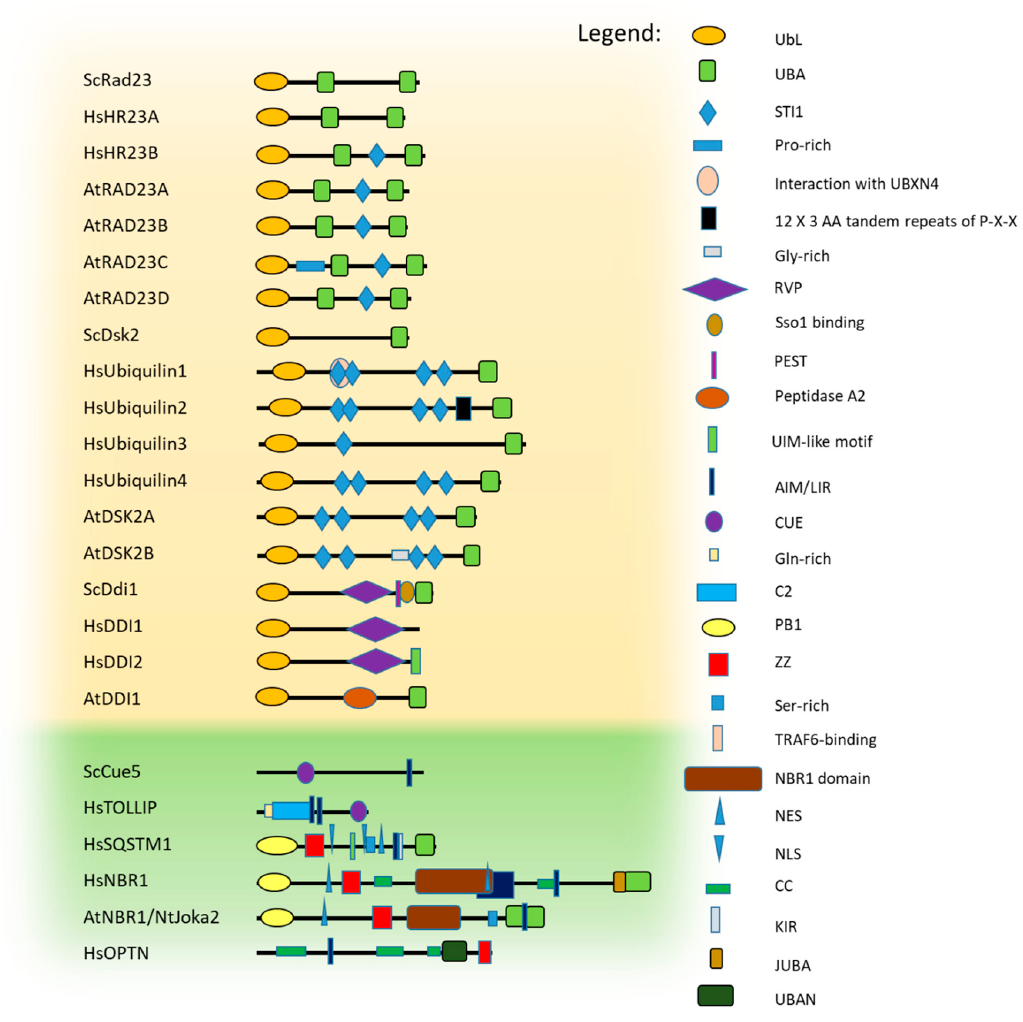
Figure 2. Ub-binding protein shuttles from yeast, mammals, and plants. Schematic representation of the domain/motif/region organization of the known Ub-binding shuttle receptors used by the proteasomal [59] and autophagic [24,65–67] protein quality control (PQC) pathways. The graphical depiction of Ub-binding modules is based on their identification using UniProt and extended by data in the published literature [68,69]. The domain/motif/regions are shown for the proteasomal ( S. cerevisiae Rad23 (P32628), H. sapiens HR23A (P54725), H. sapiens HR23B (P54727), A. thaliana RAD23A (Q84L32), A. thaliana RAD23B (Q84L33), A. thaliana RAD23C (Q84L31), A. thaliana RAD23D (Q84L30), S. cerevisiae Dsk2 (P48510), H. sapiens ubiquilin1 (Q9UMX0), H. sapiens ubiquilin2 (Q9UHD9), H. sapiens ubiquilin3 (Q9H347), H. sapiens ubiquilin4 (Q9NRR5), A. thaliana DSK2A (Q9SII9), A. thaliana DSK2B (Q9SII8), S. cerevisiae Ddi1 (P40087), H. sapiens DDI1 (Q8WTU0), H. sapiens DDI2 (Q5TDH0), A. thaliana DDI1 (Q1EBV4)), and autophagic shuttles ( S. cerevisiae Cue5 (Q08412), H. sapiens TOLLIP (Q9H0E2), H. sapiens SQSTM1 (Q13501), H. sapiens NBR1 (Q14596), A. thaliana NBR1 (Q9SB64), N. tabacum Joka2 (F8RP79), and H. sapiens OPTN (Q96CV9)). All proteins and domains are drawn to scale. UbL, Ubiquitin-like. UBA, Ubiquitin-associated. STI1, stress-inducible 1. UBXN4, Ubiquitin-regulatory X domain-containing protein 4. RVP, retroviral protease fold domain. PEST, protein rich in Pro, Glu, Ser and Thr. UIM, Ub-interacting motif. AIM/LIR, ATG8-interacting motif/LC3-interacting region. CUE, coupling of Ub-conjugation to ER degradation. C2, Ca +2 -dependent membrane-targeting module. PB1, Phox and Bem1. ZZ, Zinc finger. TRAF6, TNF receptor-associated factor 6. NBR1, Neighbor of BRCA1. NES, Nuclear Export Signal. NLS, Nuclear Localization Signal. CC, coiled-coil. KIR, KEAP1 (Kelch-like ECH-associated protein 1)-interacting region. JUBA, Juxta-UBA. UBAN, UBD Ub-binding in A20-binding inhibitor of NF- κ B (ABIN) proteins and NF- κ B essential modulator